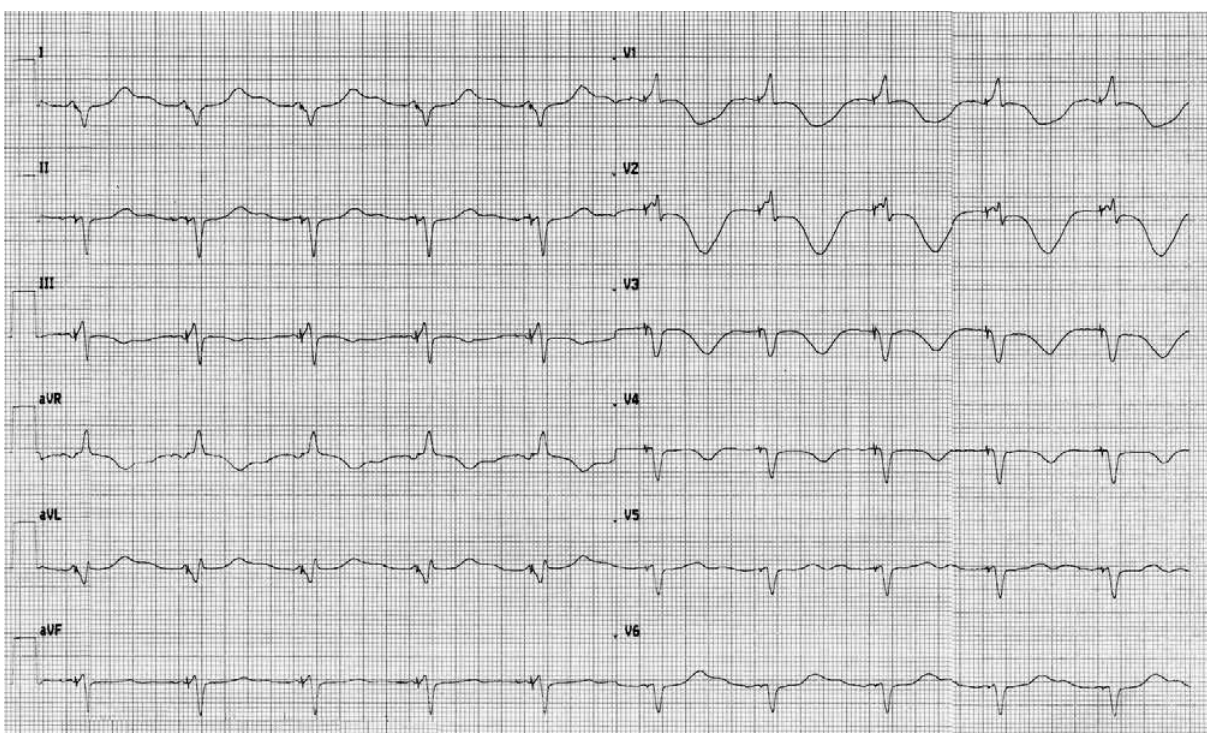
Figure 3: Follow-up ECG. Narrowed QRS complexes to 120 ms and shortened corrected QT interval to 480